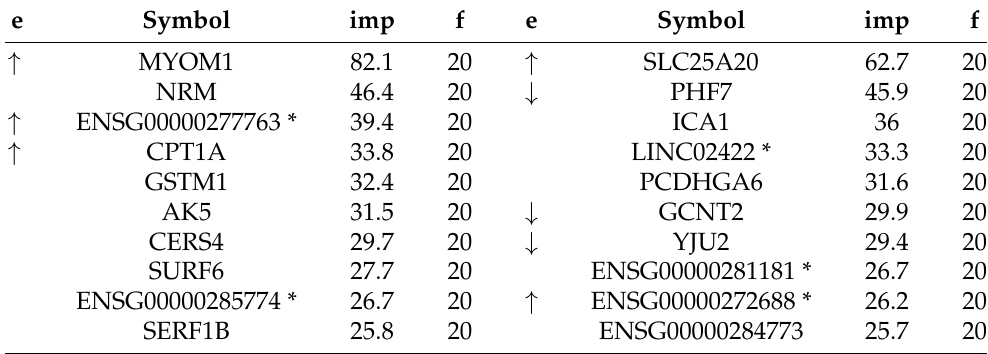
Table 3. List of the 20 most important protein coding genes and lincRNAs, ordered by importance. LincRNAs are marked with an asterisk. For each gene, four attributes are listed: (i) Up-arrow/Down arrow: significant over/under-expression in PD subjects compared to HC; (ii) HGCN HUGO Gene